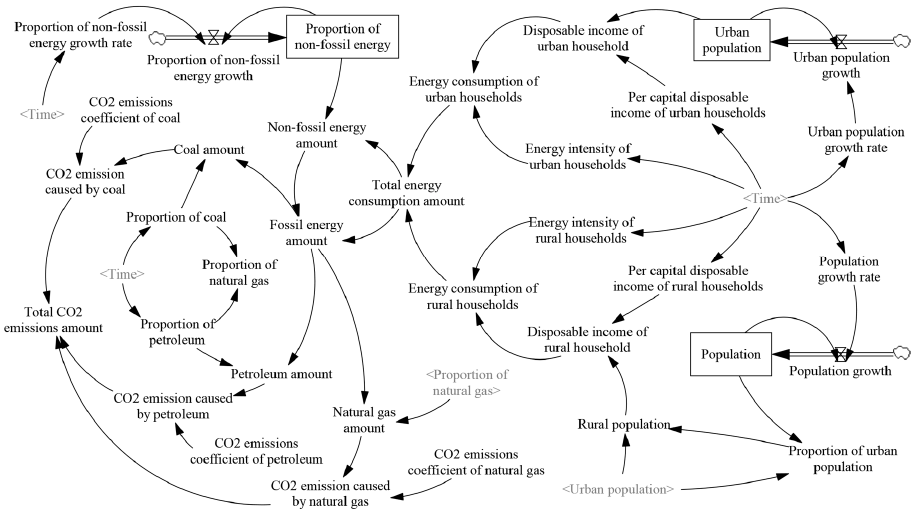
Figure 9. Stock-flow diagram for the SD model of household CO 2 emissions in China.